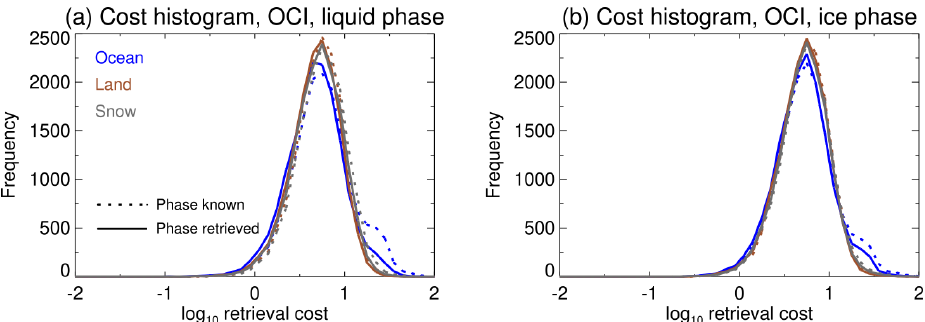
Figure 10. Retrieval cost histograms for the simulated single-layer cloud systems for OCI. Solid and dashed lines show results for best-fit phase vs. known true phase respectively. Blue, brown, and grey indicate ocean-like, land-like, and snow-like simulations. Panel (a) shows results for liquid-phase simulations and (b) for ice-phase